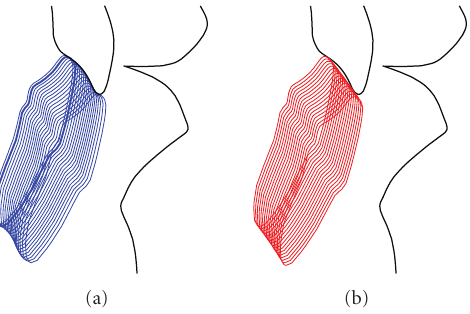
Figure 2: (a) simulation of articulator motion for an 8mm pro- trusion, considering an exact contact between incisors belonging to a healthy man ( MODE A ). (b) Envelope of incisors reconstructed using the contact between a conventional flat incisal table and the incisal pin ( MODE B-flat ).